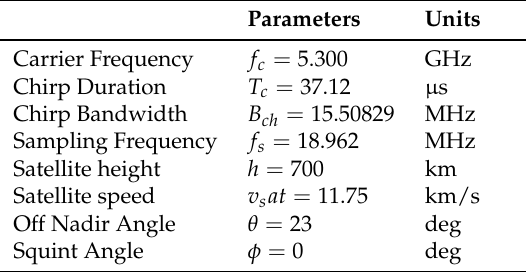
Table 1. Parameters used to simulate raw SAR